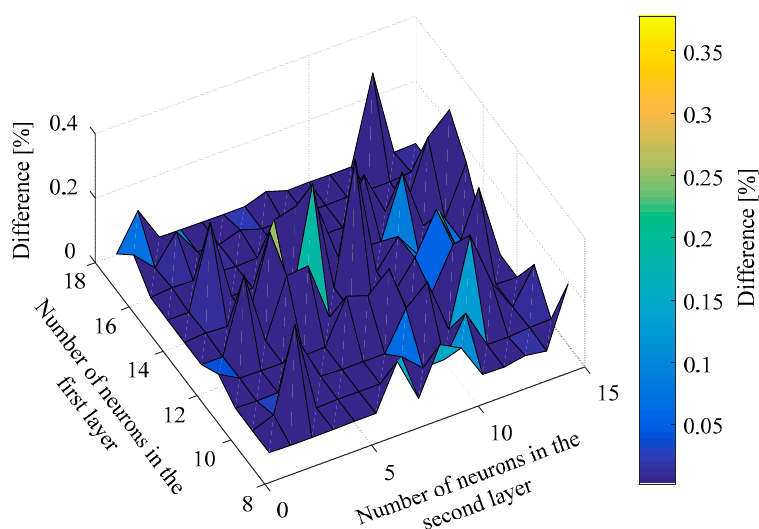
Figure 5. Validation of the feed-forward backpropagation network (FFBN) when the network consisted of two hidden layers.